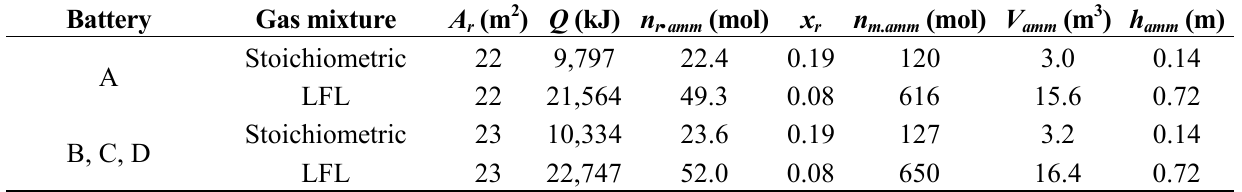
Table 9. Maximum allowed build-up, under the radiating heat constraint.